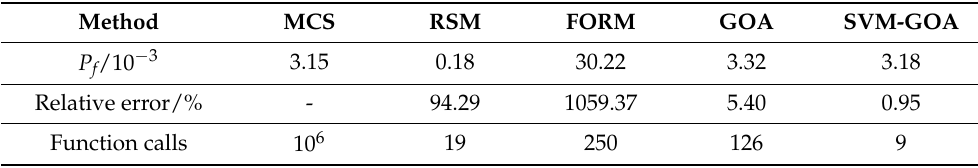
Table 6. Comparison of calculation results of Case 2.